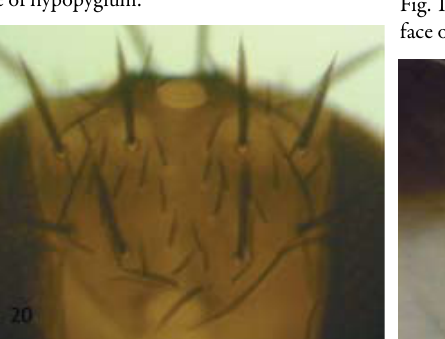
Fig. 20. Rhynchomicropteron species 3 male, frons.